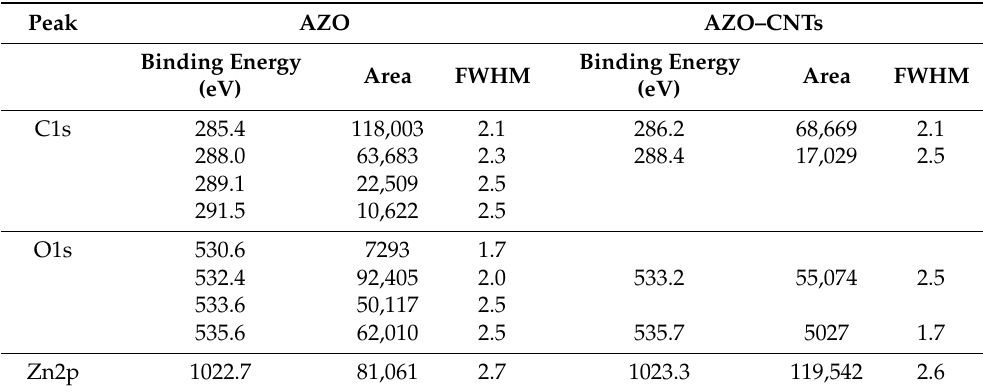
Table 1. Results of the XPS peaks deconvolution for AZO–NPs and AZO–CNT samples (from Figure S2). Peak AZO AZO–CNTs Binding Energy Area (eV)